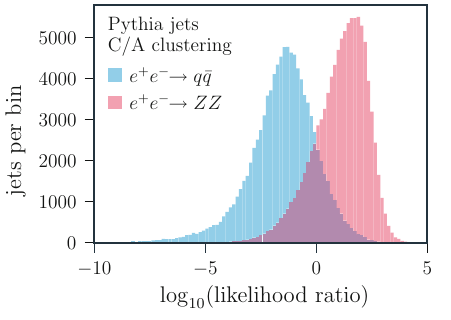
Fig. 12 (Left) Likelihood ratio P Z ( jet )/ P q ( jet ) evaluated on Pythia jets in the validation set. (Right) ROC curve for discrimination based on Junipr ’s likelihood ratio, in comparison to the empirical 2D distri-